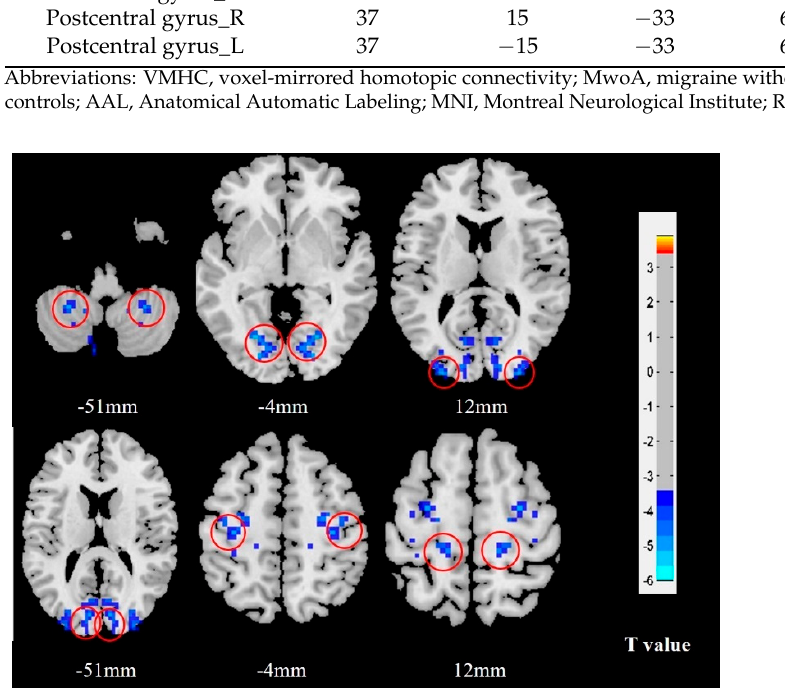
Table 2. Alterations in VMHC between MwoA patients and HCs.